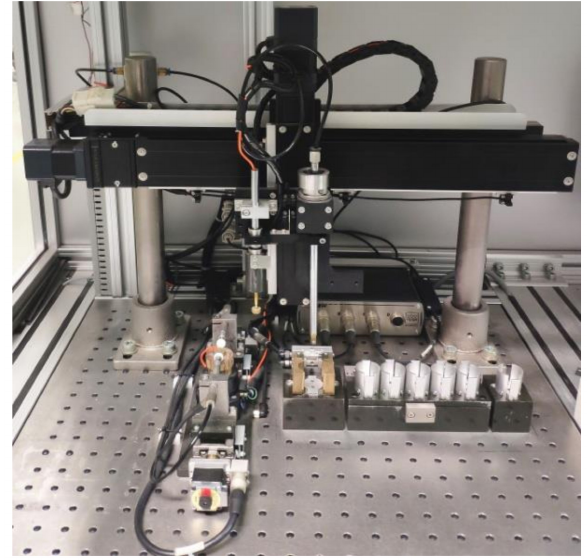
Figure 11. The physical sorting system for the piezoelectric transducer